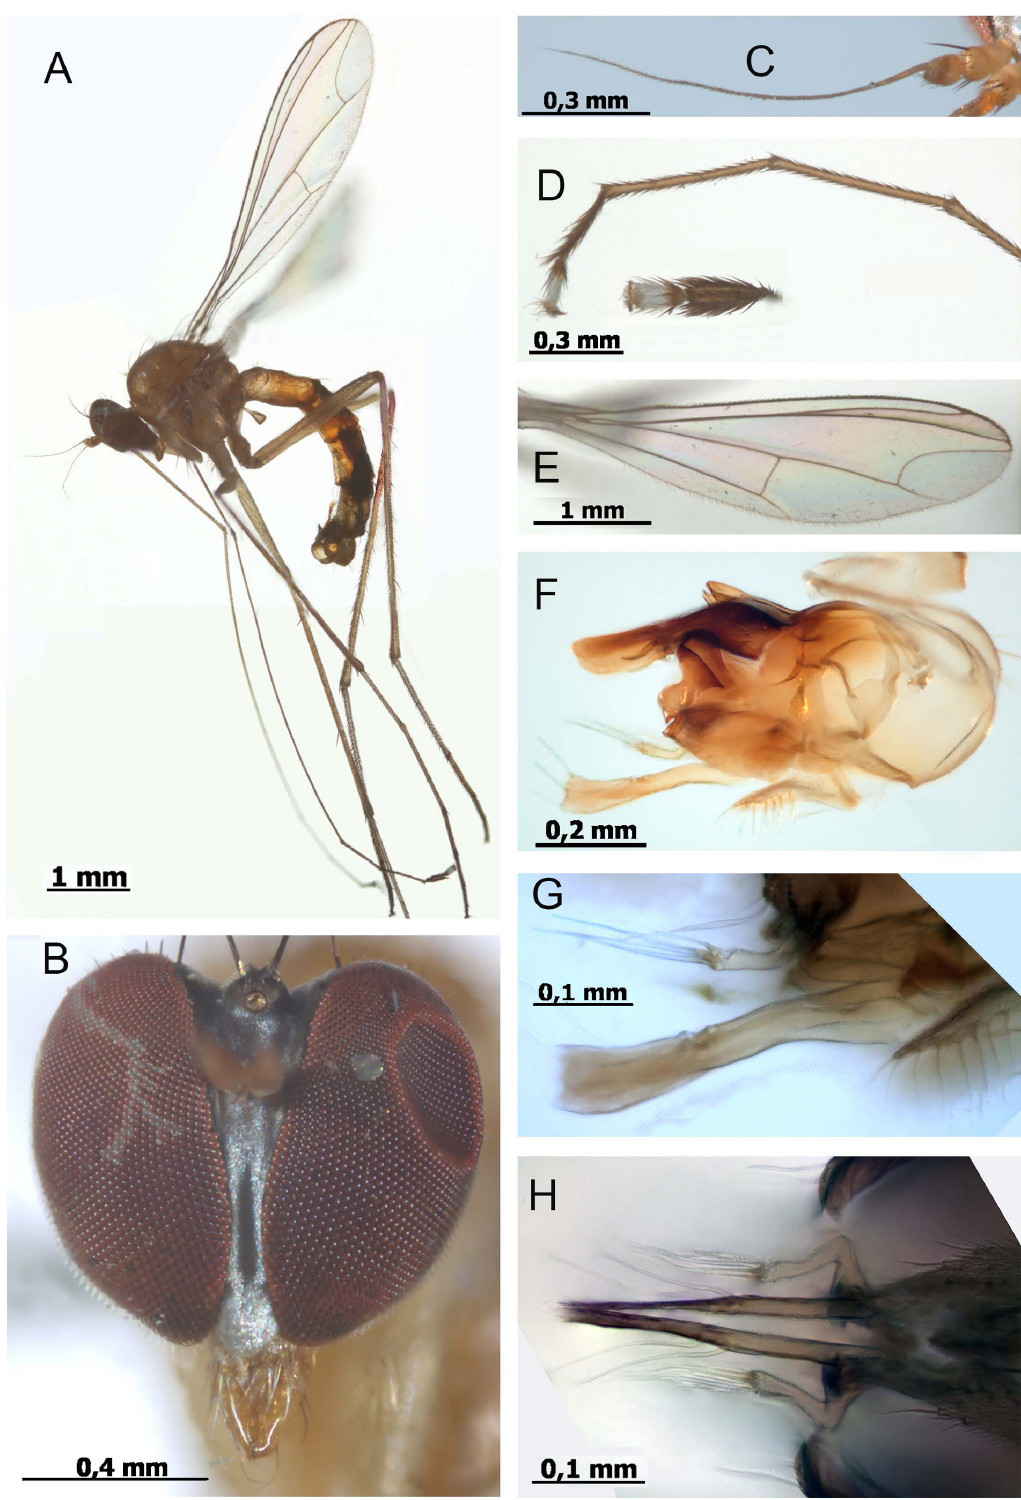
Fig. 8. Amblypsilopus andasibensis sp. nov. Holotype, ♂ (SMNHTAU). A . Habitus. B . Head. C . Antenna. D . Fore tarsomeres 2–5, lateral view, with inset showing segments 4–5, dorsal view. E . Wing. F . Hypopygium, left lateral view, reflected light. G . Cercal lobes, lateral view, transmitted light. H . Cercal lobes, dorsal view, transmitted